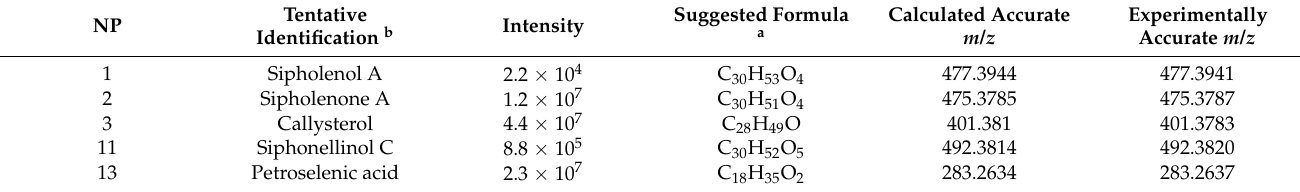
Figure 1. Identified compounds of C. siphonella DCM fraction by dereplication with LC-HRESIMS. Table 2. High features of compounds (ranked by peak intensity) detected in DCM fraction of C. siphonella after dereplication of its